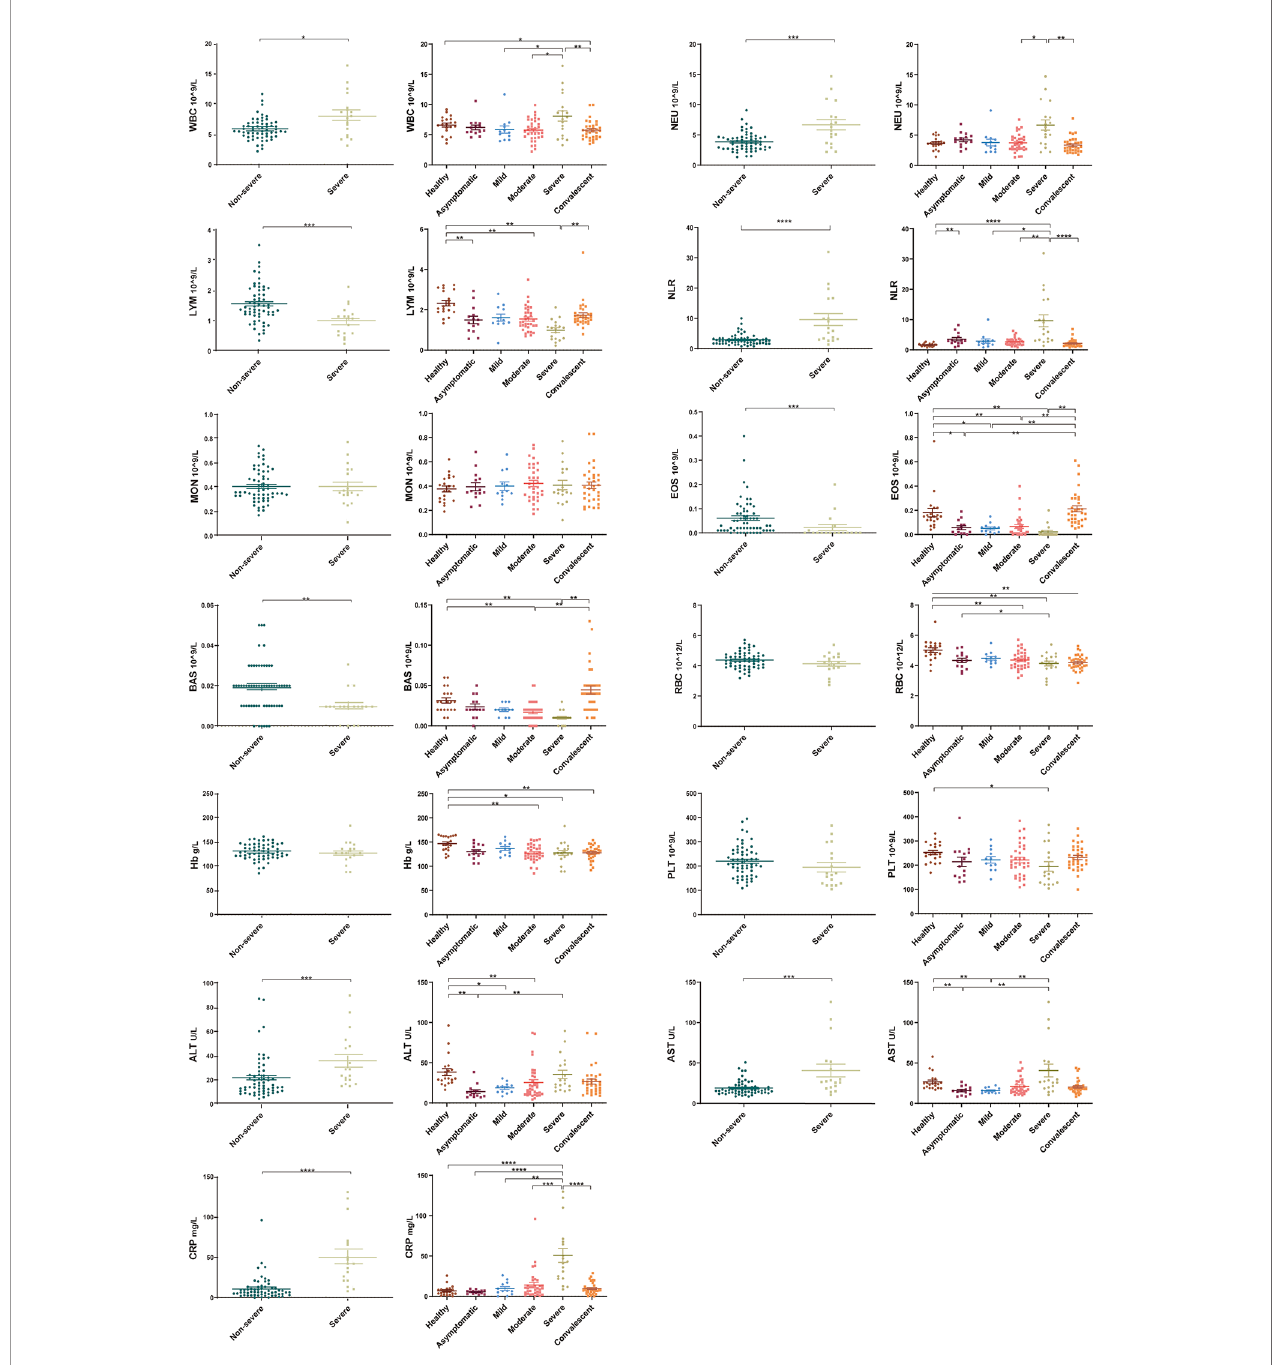
FIGURE 1 | Laboratory parameters from different COVID-19 severity groups (asymptomatic, mild, moderate, severe and convalescent) and healthy controls. Differential levels of routine complete blood count, hemoglobin (Hb), C-reaction protein (CRP) and liver function across different severity groups. White blood cell count, neutrophil count, neutrophil-lymphocyte ratio (NLR), alanine aminotransferase and aspartate aminotransferase levels were higher in the severe group compared with the non-severe groups (asymptomatic, mild, and moderate) ( P < 0.05). Lymphocyte and eosinophil counts were signi fi cantly decreased in the severe group compared with the non-severe group ( P < 0.001), with a trend to recovery in the convalescent group. Healthy control (n=20), asymptomatic group (n=14), mild group (n=12), moderate group (n=34), severe group (n=18), non-severe group (n=60), convalescent group (n=33). Signi fi cance is denoted as * P < 0.05, ** P < 0.01, *** P < 0.001, and **** P < 0.0001. WBC, White blood cell count; NEU, Neutrophils count; LYM, Lymphocytes count; NLR, neutrophil-lymphocyte ratio; MON, Monocyte count; EOS, Eosinophil count; BAS, Basophils count; RBC, Erythrocyte count; Hb, Haemoglobin; PLT, Platelet count; ALT, Alanine aminotransferase; AST, Aspartate aminotransferase; CRP, C-reactive